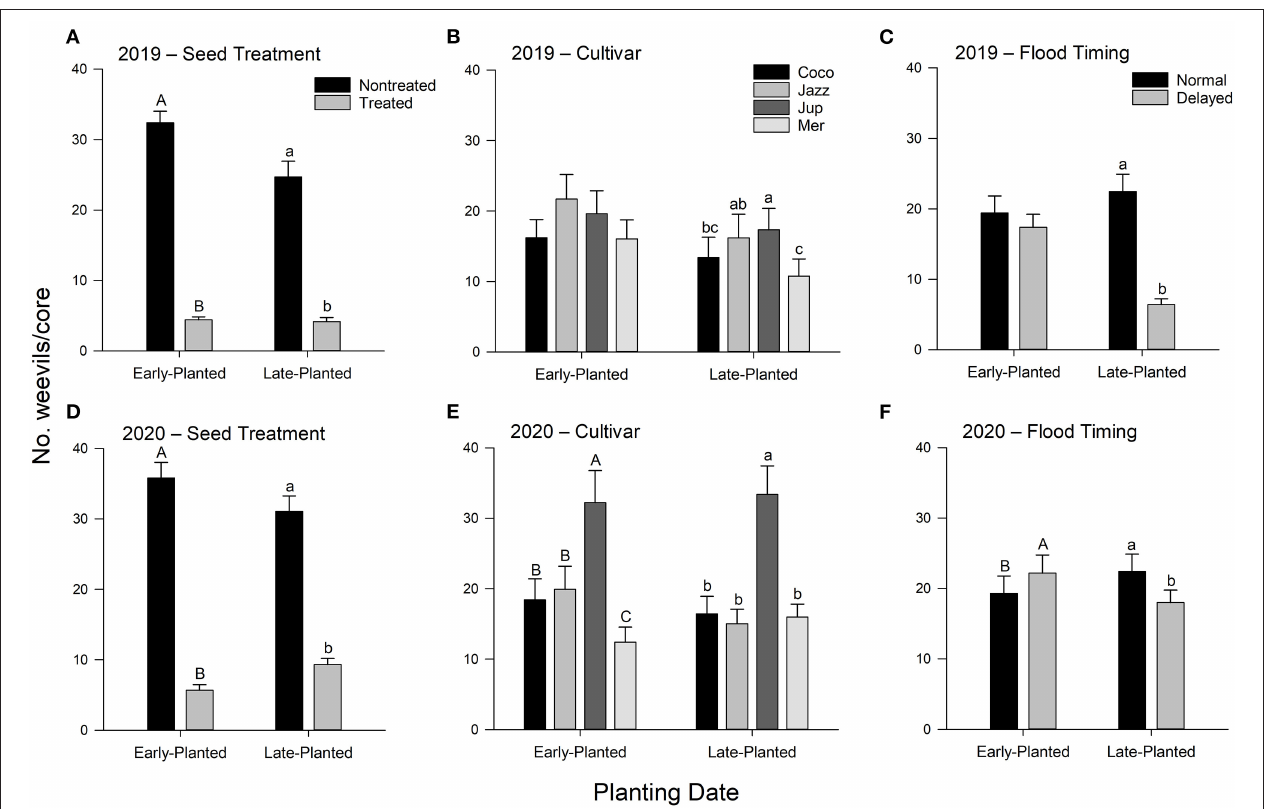
FIGURE 1 | Mean ( + SEM) number of immature rice water weevils per root-soil core as affected by (A,D) insecticidal seed treatment, (B,E) rice cultivar, and (C,F) flood timing main effects, Crowley, Louisiana, 2019–2020. Analyses were conducted separately by year and planting date. Bars accompanied by the same letter do not differ significantly (Tukey’s HSD: α >